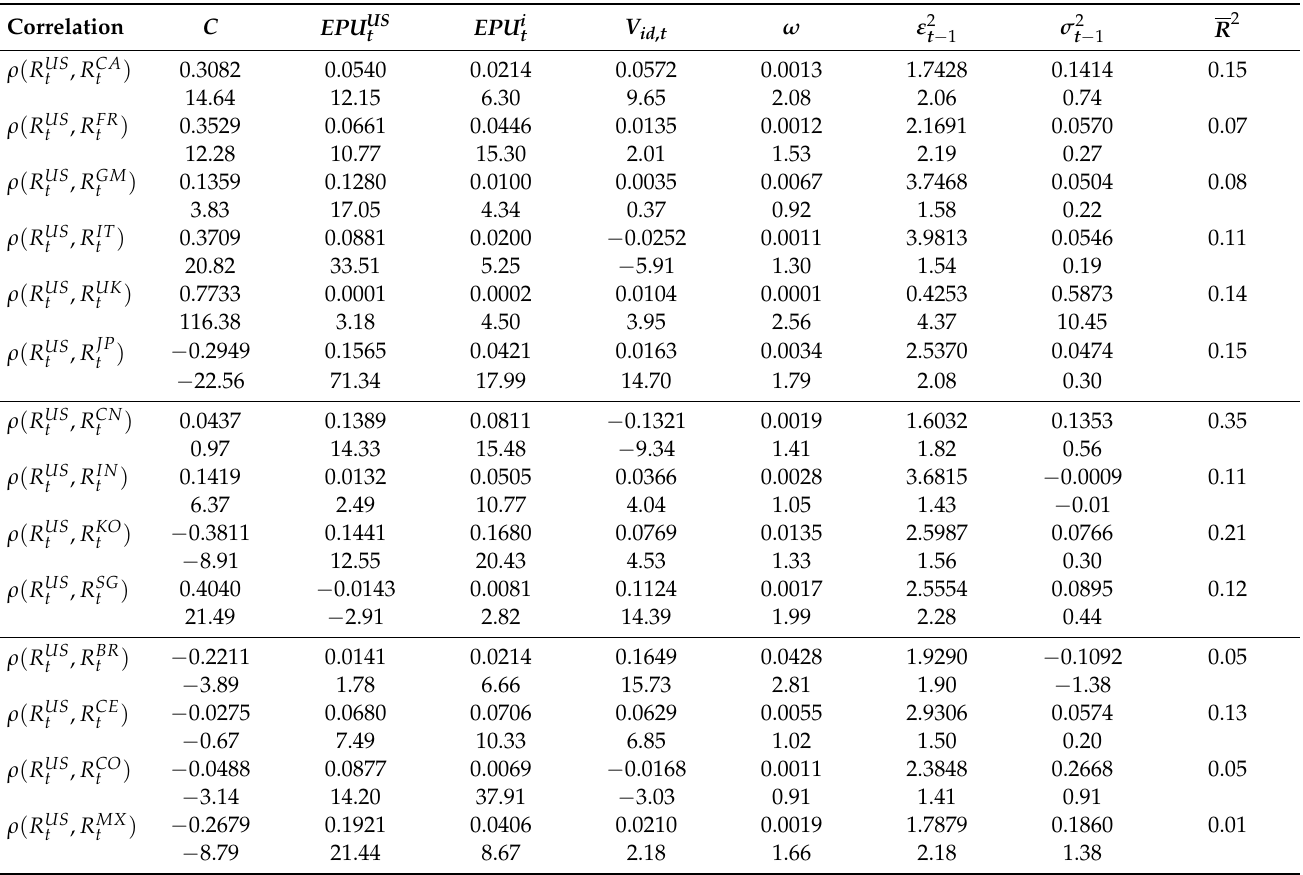
Table 10. Estimates of global–U.S. stock return correlations in response to economic uncertainties for the pre-COVID-19